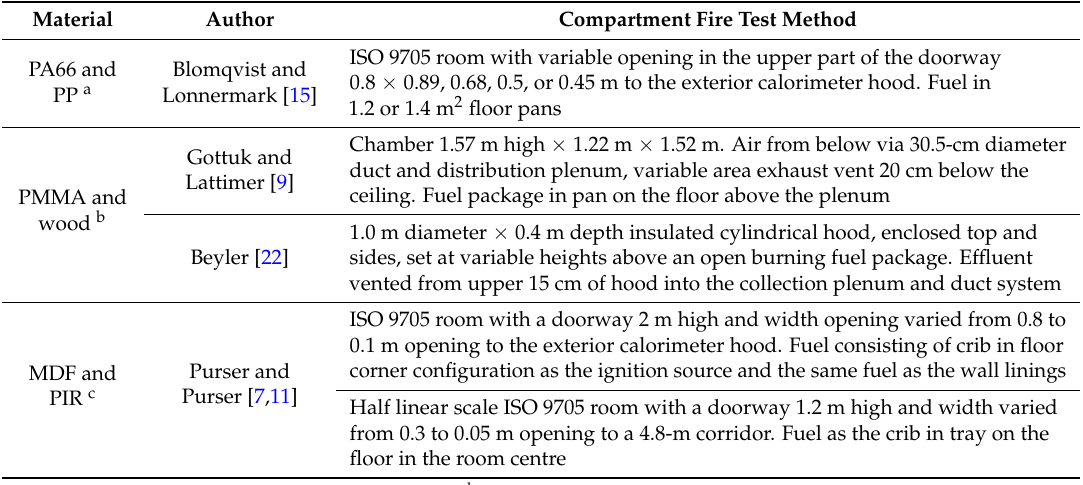
Table 1. Compartment fire apparatus and test methods used for different